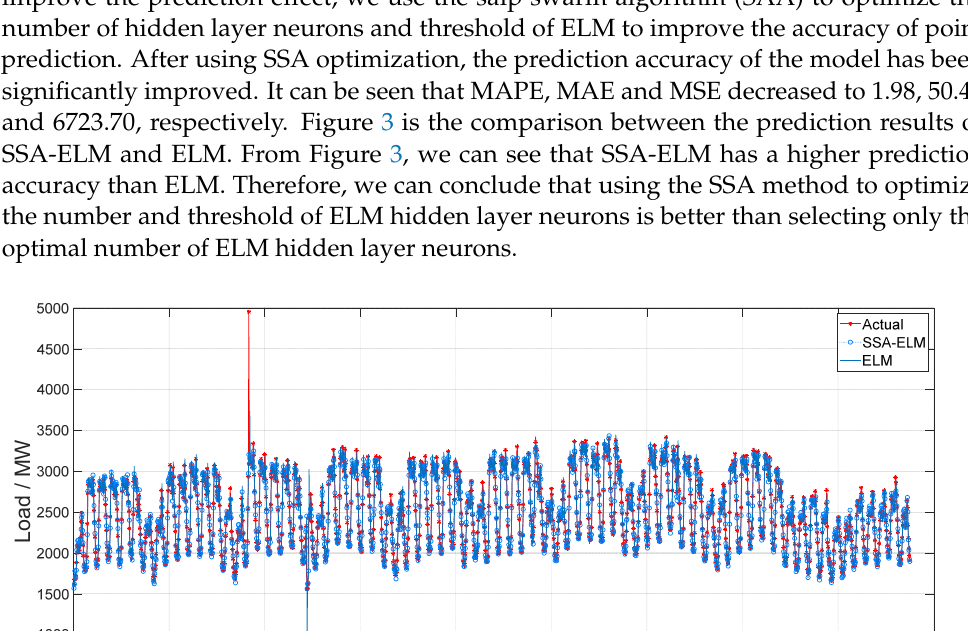
Table 5. Comparison of the reconstructed model and the decomposition model.